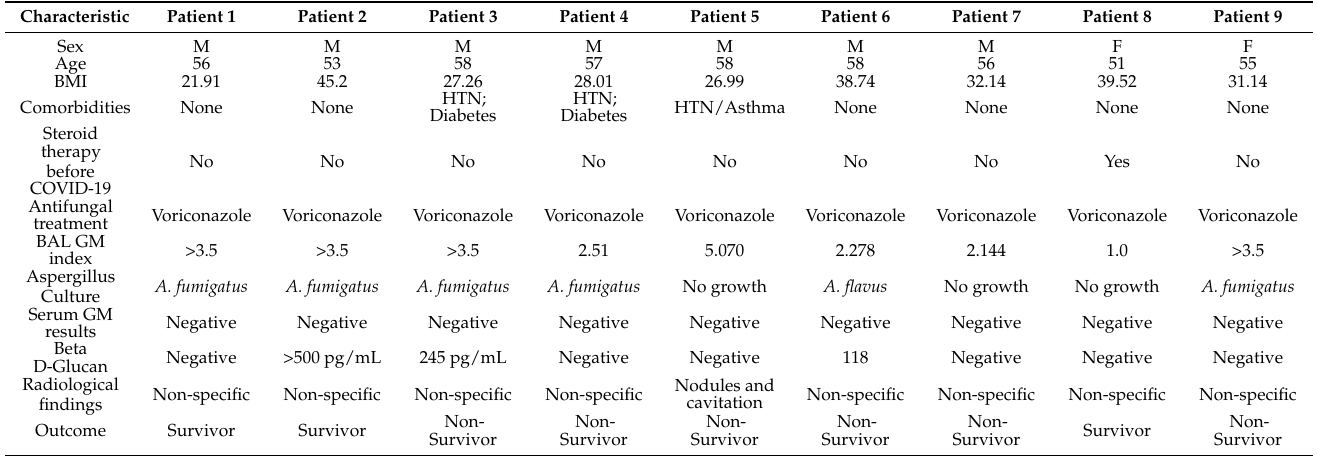
Table 2. Clinical and mycological characteristics of the nine patients with COVID-19-associated pulmonary aspergillosis.